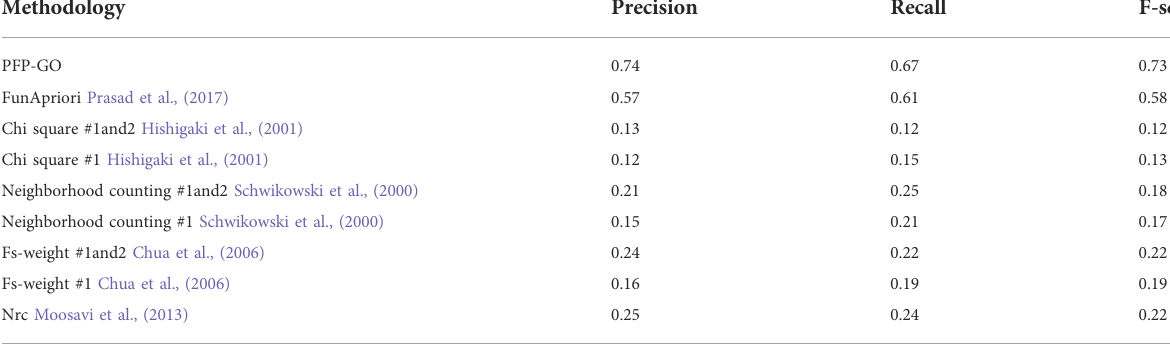
TABLE 3 Performance analysis of PFP-GO with other methods based on PPI network.